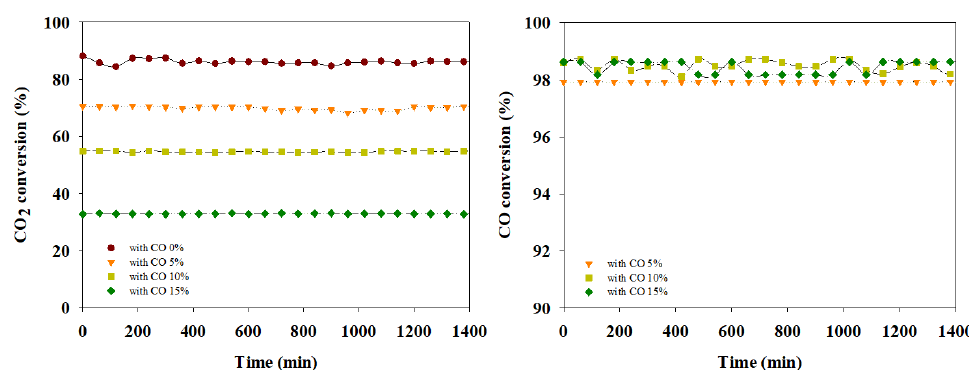
Figure 9. Result of a prolonged COx methanation reaction at 300 °C.